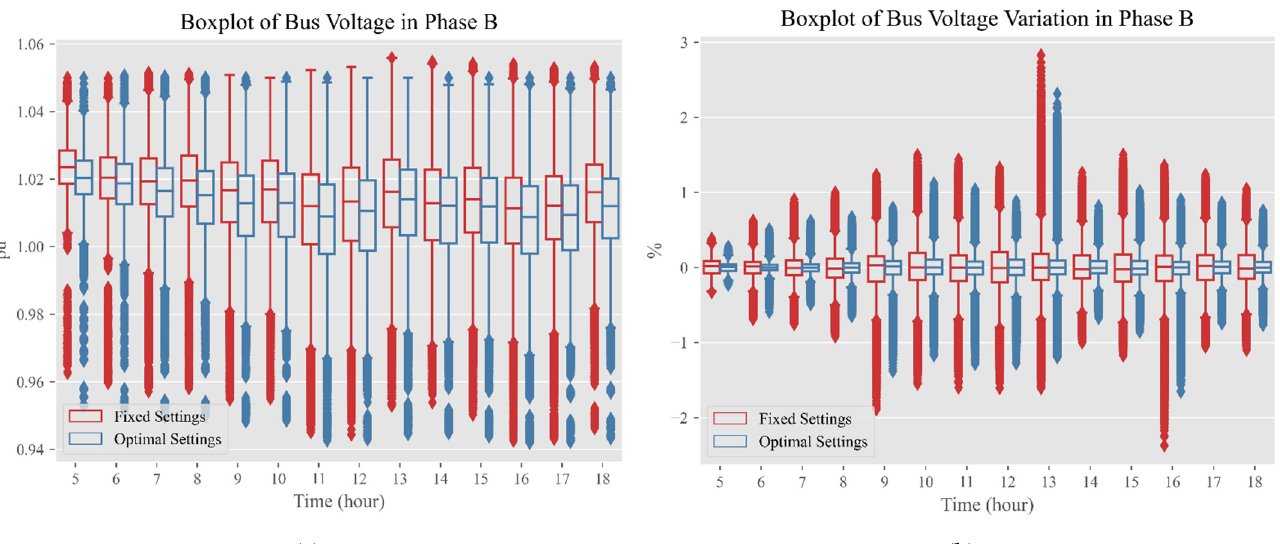
( b ) Figure 10. Boxplots of ( a ) bus voltage and ( b ) voltage variation in phase C for each hour with fixed and optimal volt–var control settings.